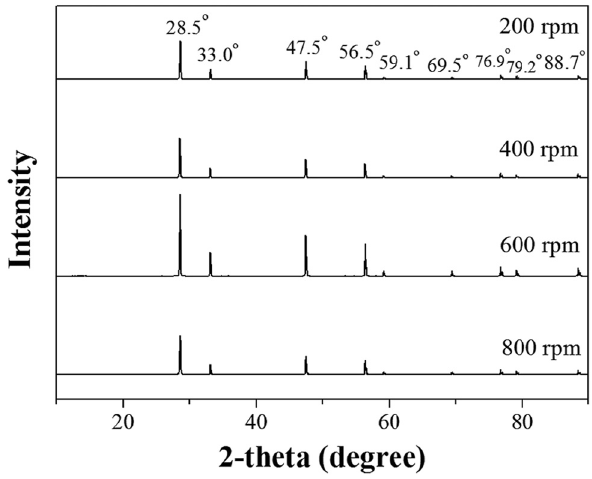
Figure 4: XRD patterns of CeO 2 synthesized using 200, 400, 600, and 800 rpm stirring rates at 3% oxalic